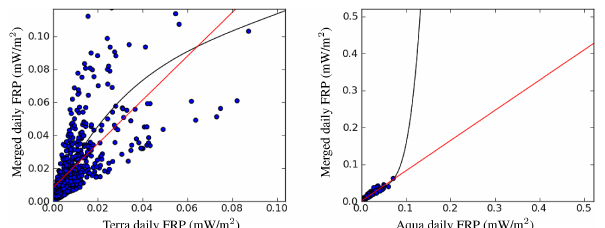
Figure 6. Scatter plot of Terra-(left) and Aqua(right) daily FRP to- gether with merged FRP. The linear regression between the two data sets is shown as a red line while the best fit non-linear regression is shown in black. Regions considered are the square that extends from 24 to 26 ◦ east and from 16 to 18 ◦ south (left) and from 36 to 38 ◦ east and 58 to 60 ◦ north (right).